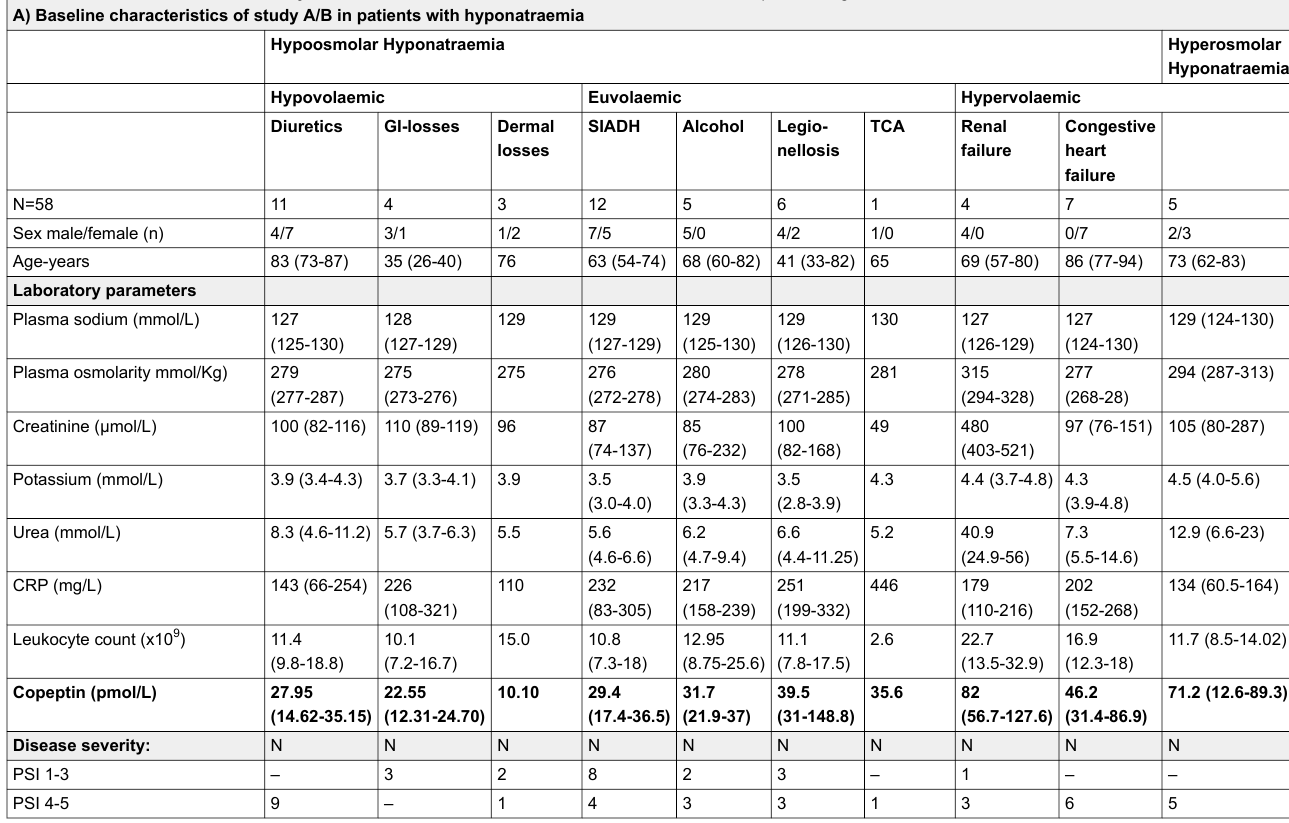
Table 1: Baseline characteristics study A/B : All Values are absolute numbers or medians and inter-quartile range A) Baseline characteristics of study A/B in patients with